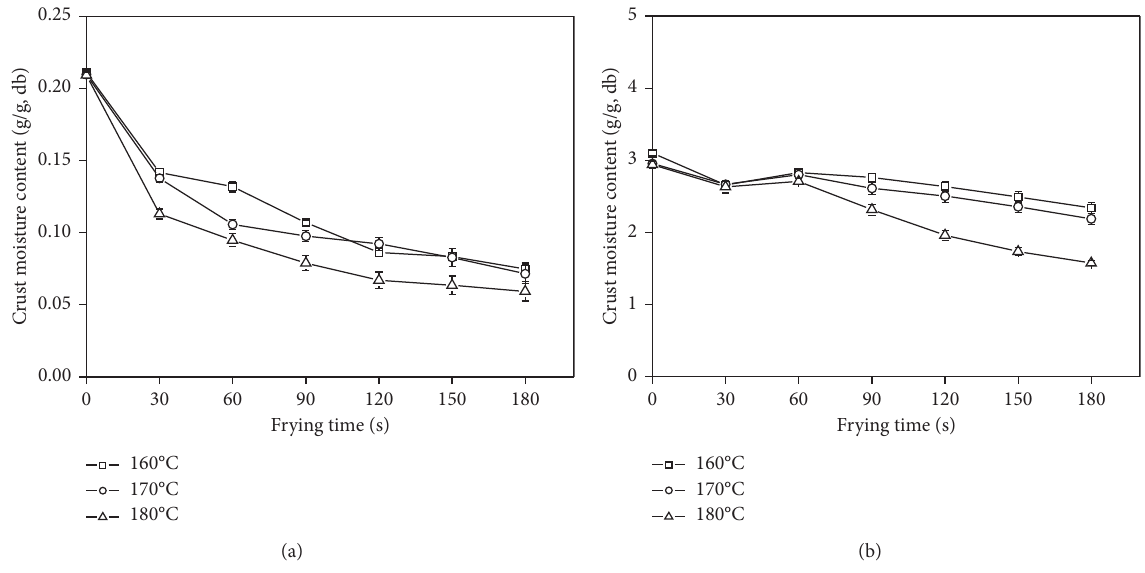
Figure 1: Crust and core moisture contents of BBFNs fried at different temperatures. (a) Crust; (b) core.